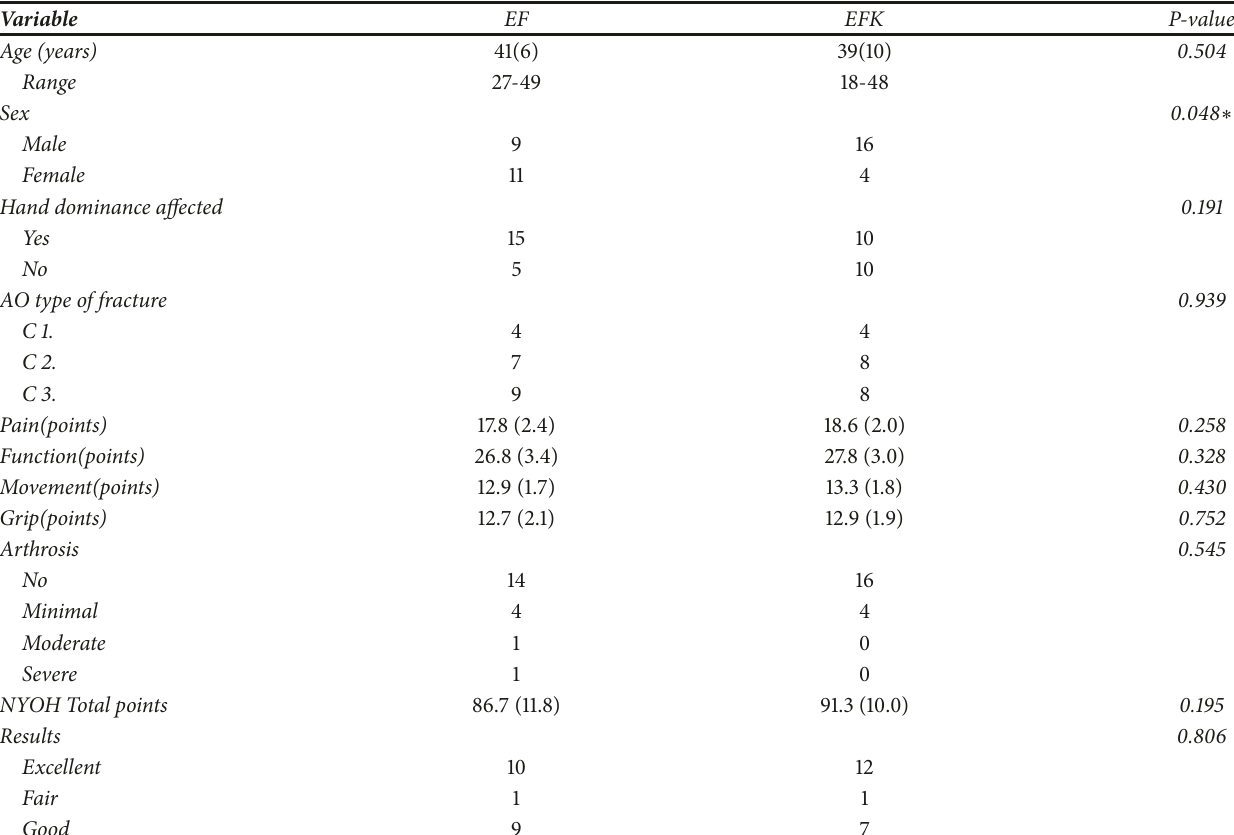
Table 1: Patients' demographics and NYOH wrist scoring scale assessment.